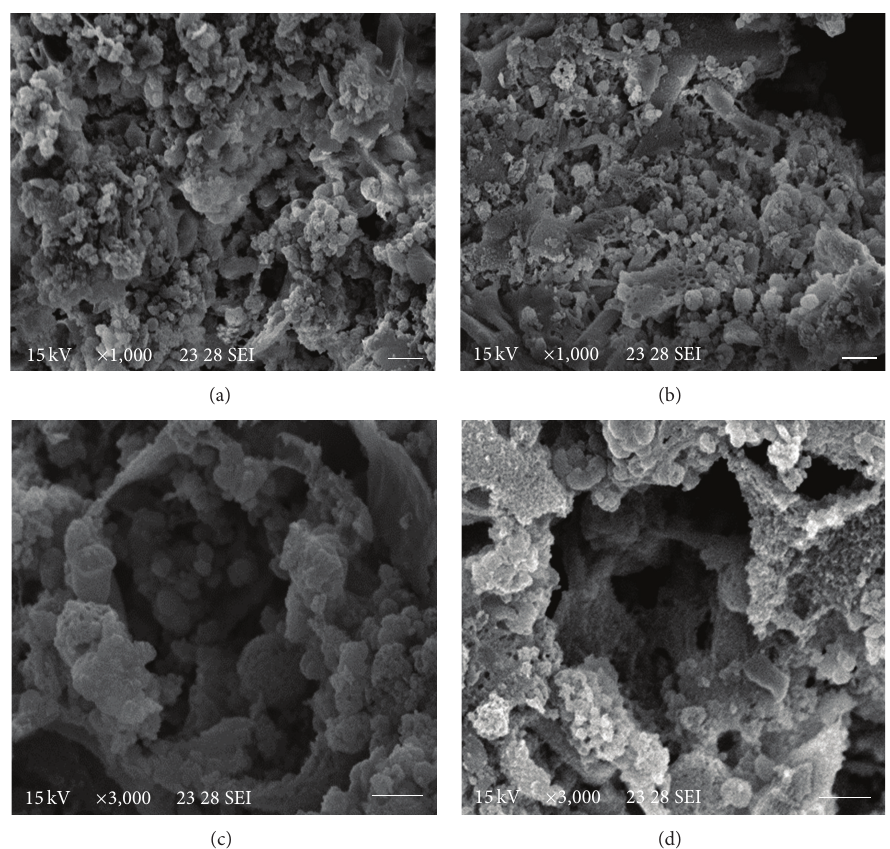
Figure 4: Scanning electron microscopy of E. granulosus larval cell aggregates incubated in vitro with different essential oils. (a) and (c) Controlcellaggregatesexhibitingthetypicaltridimensionalorganization.(b)Cellaggregatesincubatedwith10 𝜇 g/mLof R.officinalis essential oil for 7 days. (d) Cell aggregates incubated with 10 𝜇 g/mL of M. piperita essential oil for 7 days. Note the loss of the typical multicellular structure. Bar = (a) and (b) 10 𝜇 m, (c) and (d) 5 𝜇